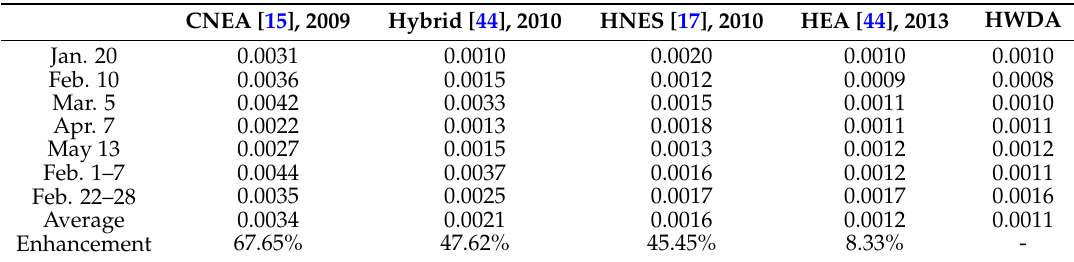
Table 5. Error variance comparison considering the year 2006 PJM (Pennsylvania-New Jersey-Mary) land market case study for 24/168 h ahead.